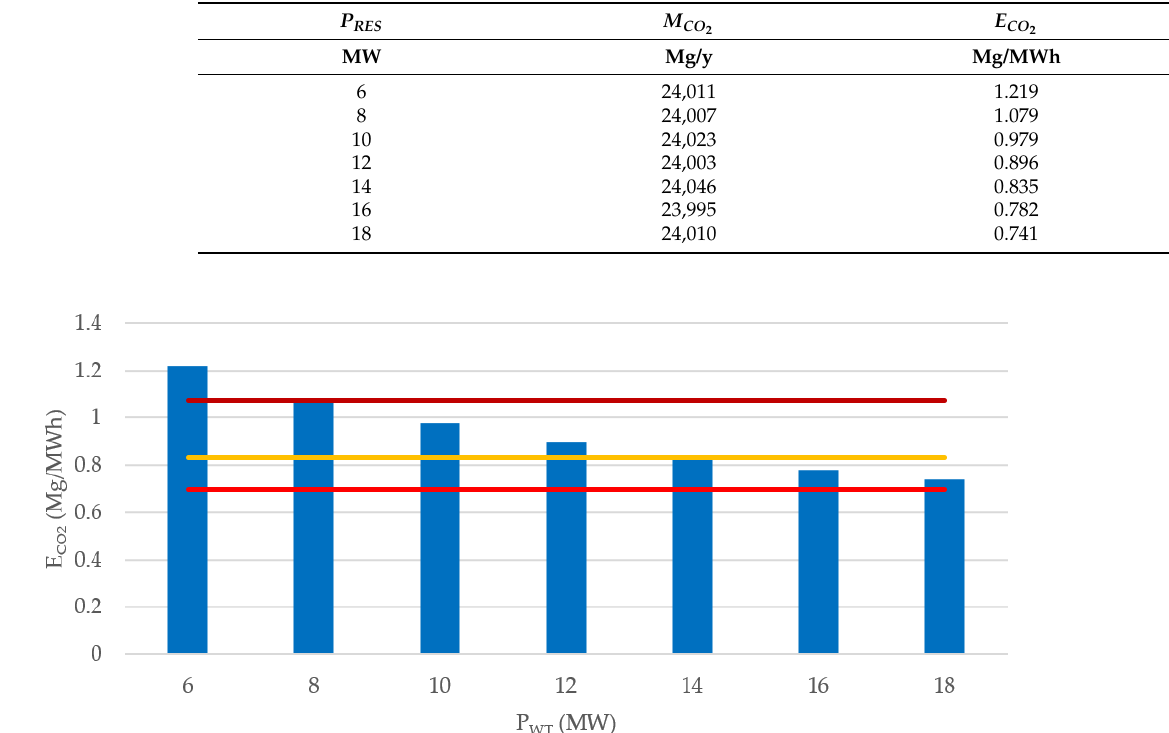
Figure 15. CO 2 emission reductions.